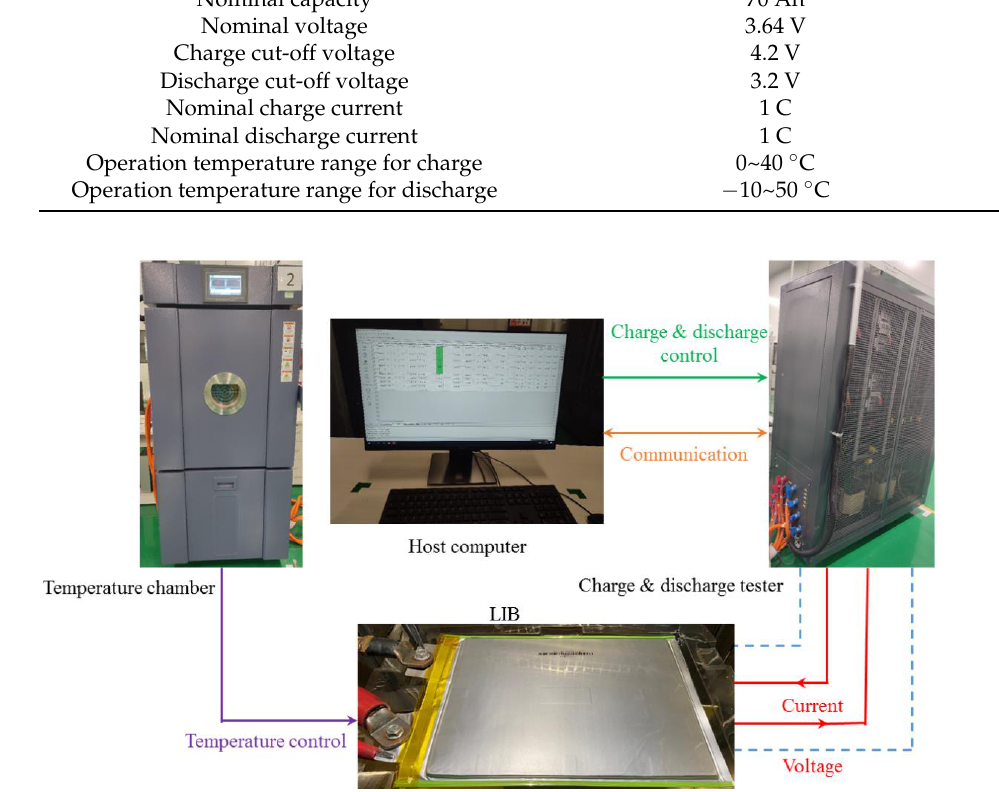
Figure 1. Schematic presentation of the test bench. Table 1. Primary design and performance parameters of the test object.